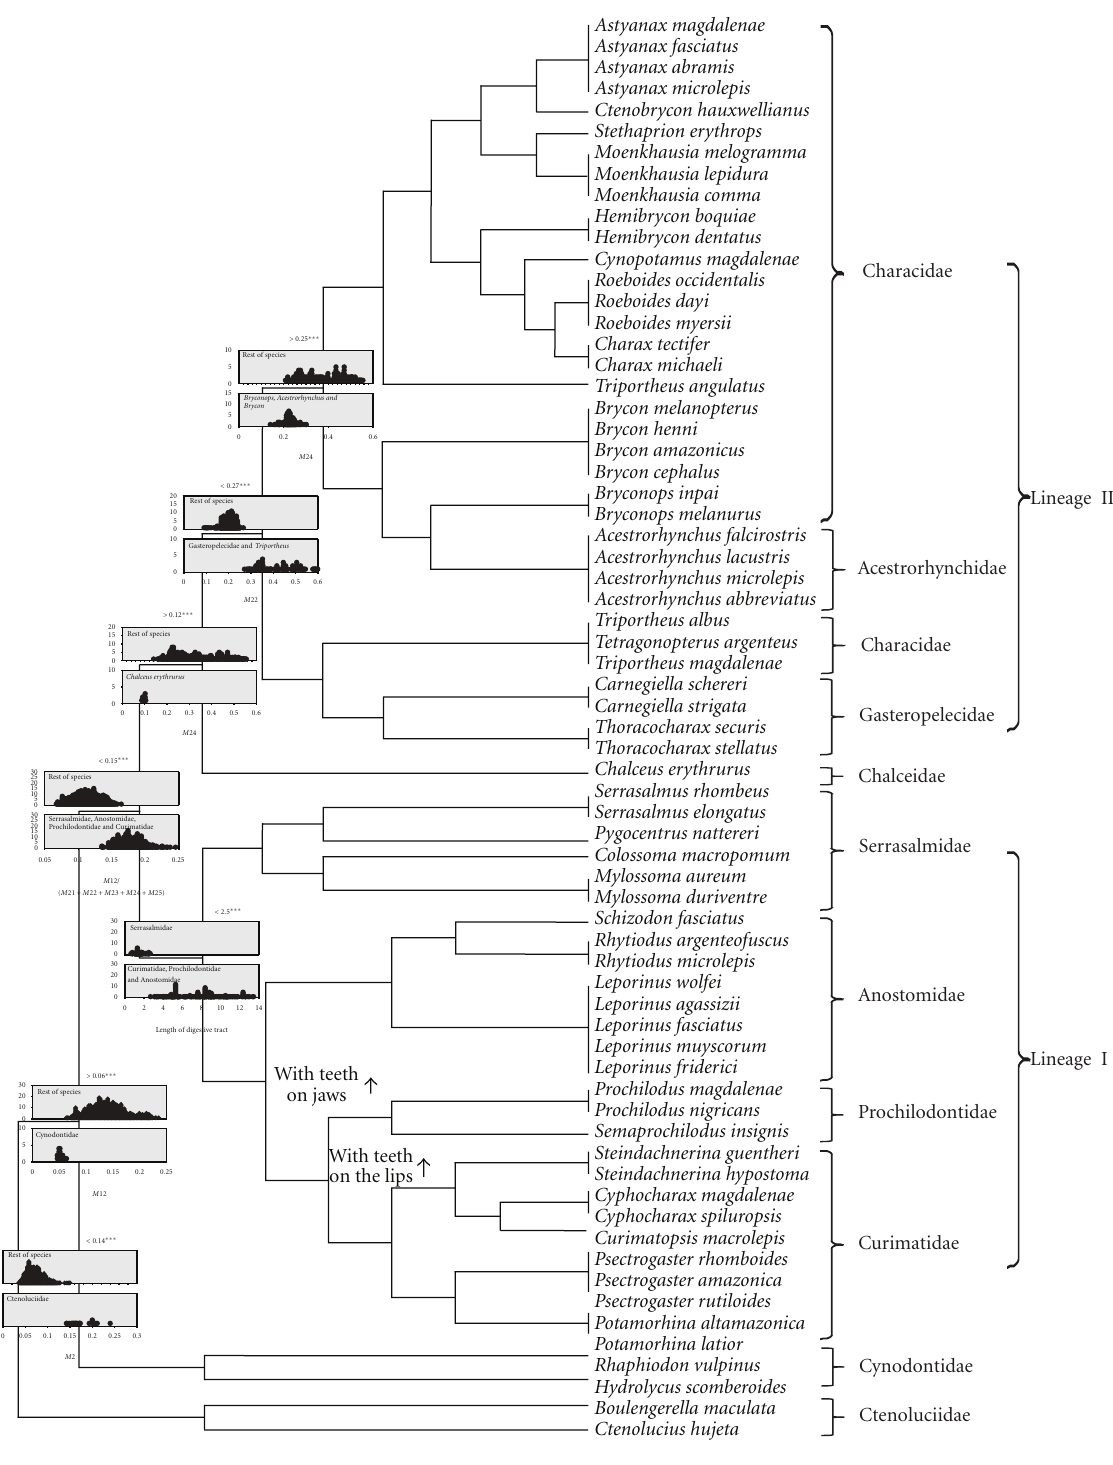
Figure 6: Tree obtained from CART analysis performed on morphological and trophic measurements of the species of the Characiformes analyzed in this study, indicating morphological measurements that discriminate each node and level of significance of di ff erences observed for each morphological measurement at each node: P < 0 . 001 ( ∗∗∗